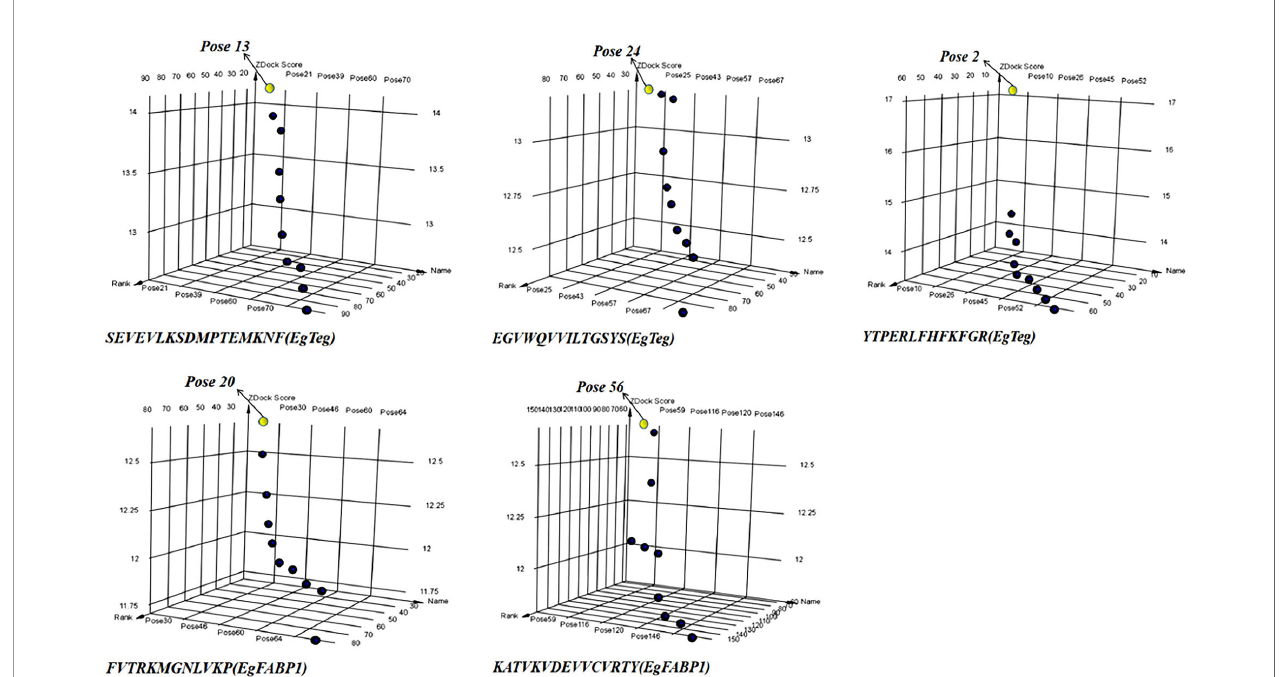
FIGURE 3 | The 3D point plot of docking poses between CD4 + T-cell epitopes and HLA-DRB1. All the yellow points were the best Pose in every docking clusters, they are Pose 13, Pose 24, Pose 2, Pose 20 and Pose 56 separately. The X-axis is the Pose Name, the Y-axis is the Pose Rank and the Z-axis is the ZDOCK Score. (For understanding the reference color in remark of the fi gure clearly, please readers refer to the web version of this